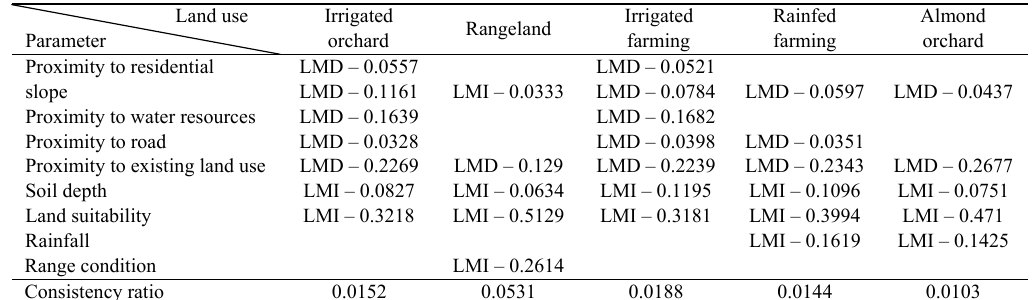
Table 3: Type of fuzzy membership function, eigenvectors of weight (values in italic) and AHP consistency ratio for each land use type